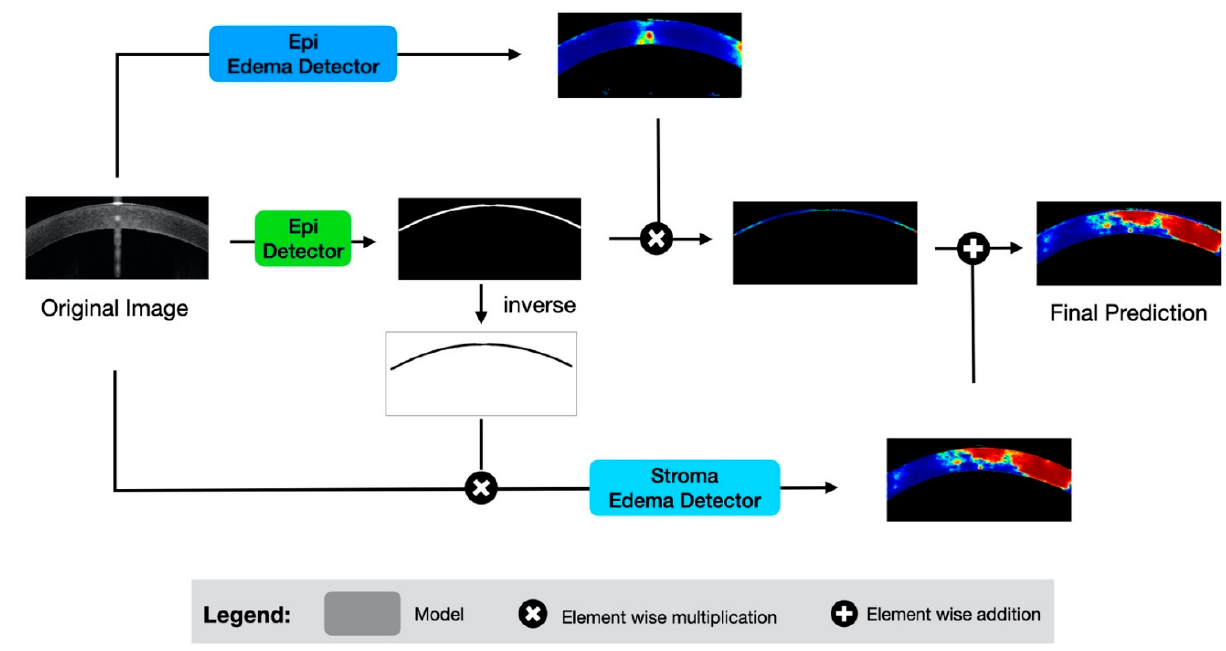
Figure 1. Pipeline description.